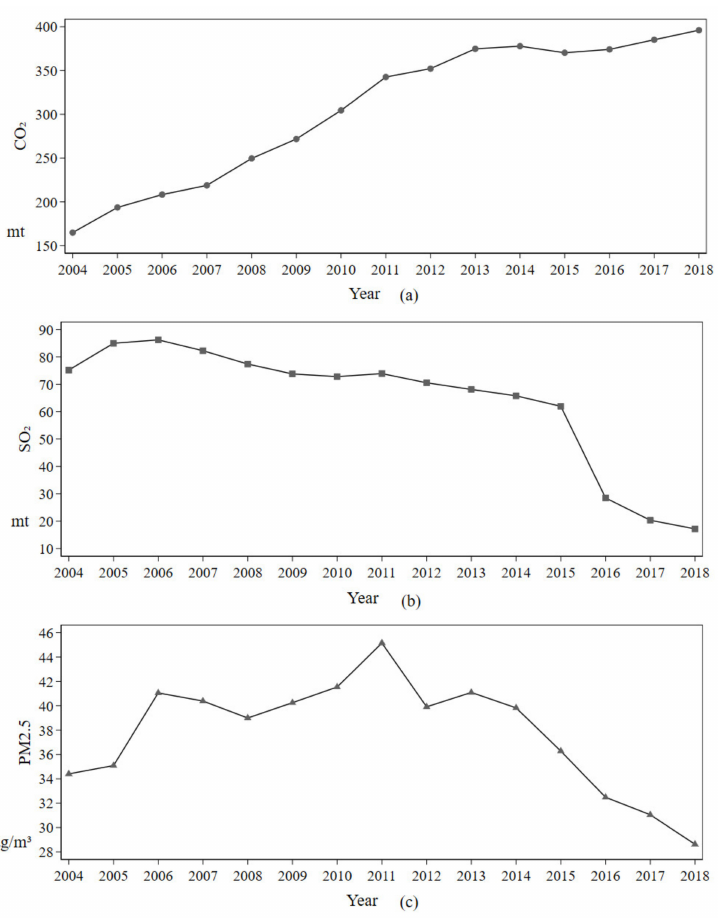
Figure 4. Pollutant mean value graph: ( a ) CO 2 yearly average. ( b ) SO 2 yearly average. ( c ) PM 2.5 yearly